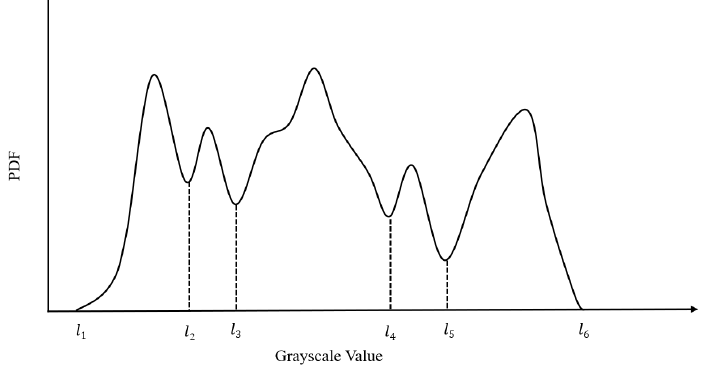
Figure 3. Schematic diagram of adaptive histogram segmentation based on local minima. The gray level in each interval is regarded as one or a group of objects, and the gray redistribution strategy of each interval is carried out. It is unreasonable to redistribute grayscales based only on the PDF values of a single grayscale. The overall grayscale distribution of the interval would be considered to determine the foreground or